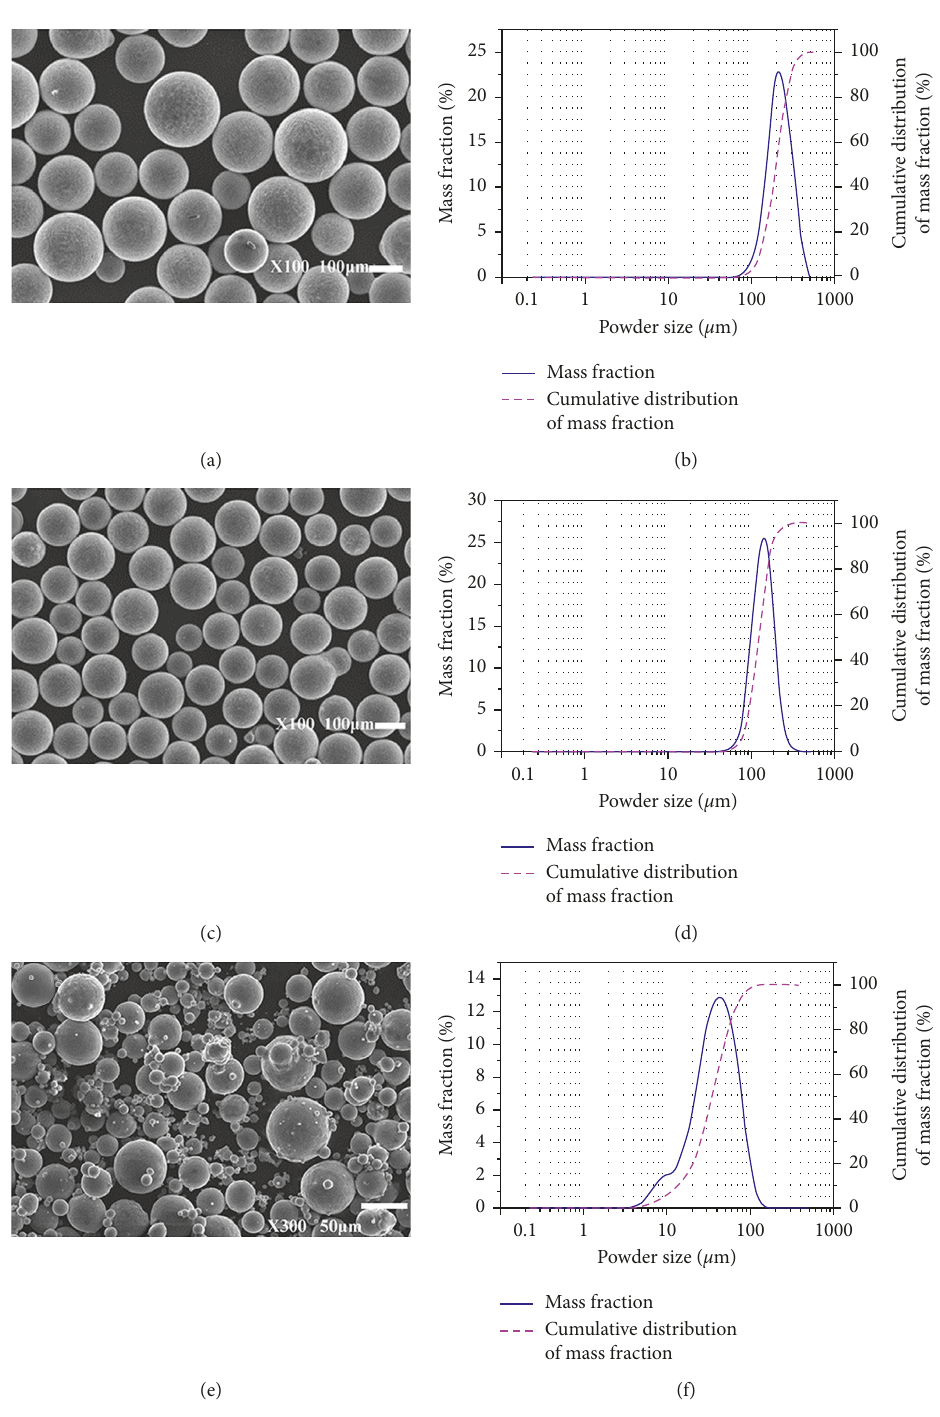
Figure 1: The morphologies of the powders 1 (a), 2 (b), and 3